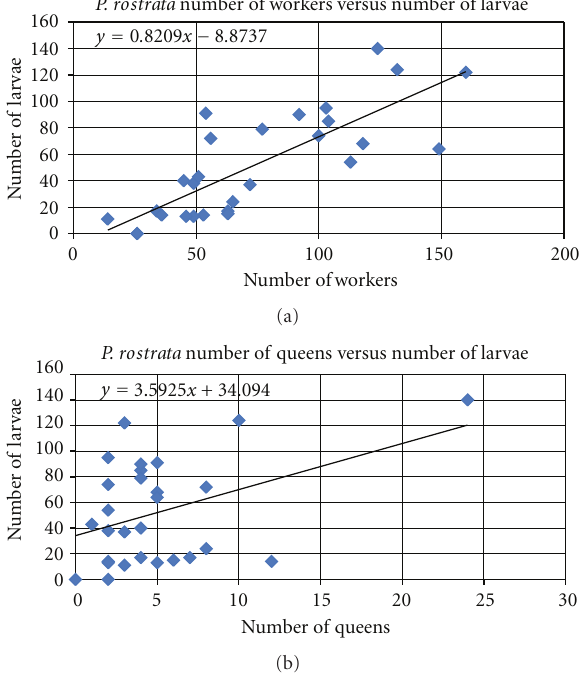
Figure 4: P. rostrata scatter plot of colonies ( N = 28): (a) workers versus larvae; (b) queens versus larvae.